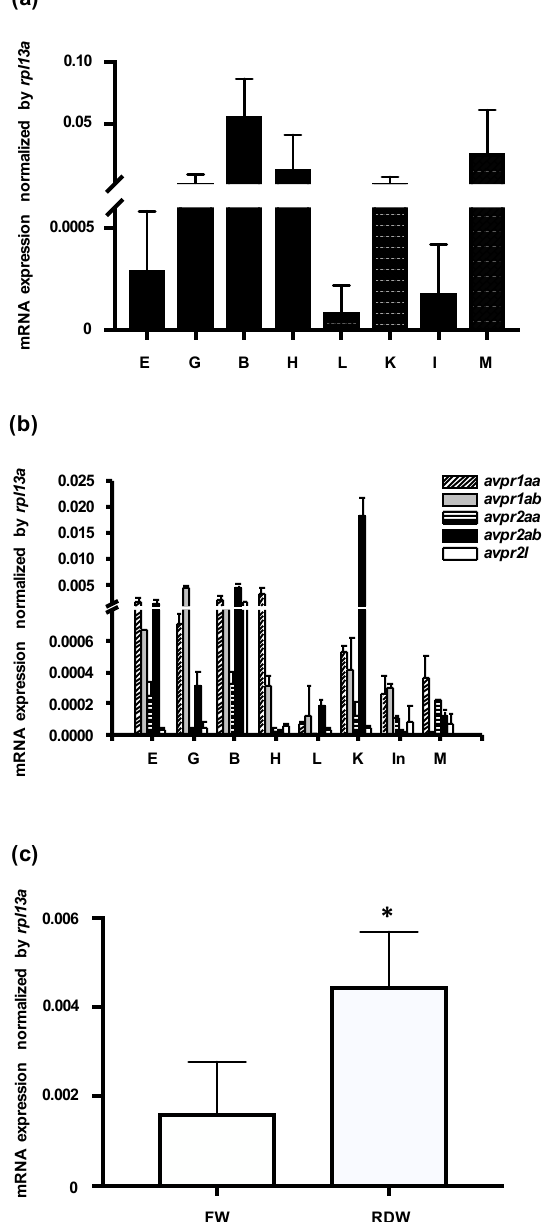
Figure 1. Expression levels of mRNAs encoding arginine vasopressin (Avp) and Avp receptors in zebrafish. Relative mRNA expression level of Avp ( a ) and five Avp receptors ( b ) in the eye (E), gill (G), brain (B), heart (H) liver (L), kidney (K), intestine (In), and muscle (M) of adult zebrafish. Values were normalized to rpl13a . Relative expression of avp in 3-days post-fertilization (dpf) embryos grown ( c ) in freshwater (FW) or RO-deionized water (RDW) for 24 h. Quantification was performed by standard qRT-PCR methods. Values are mean ± s.e.m. ( n = 4–5). Asterisk indicates significant di ff erence between the two groups, according to Student’s t -test, p <